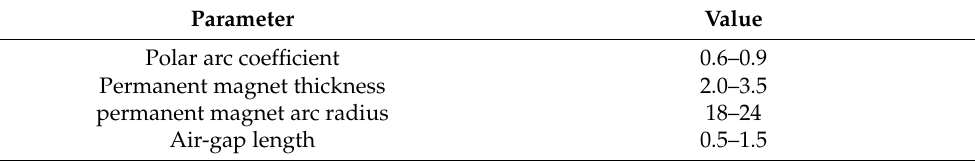
Table 2. Parameters of the model.